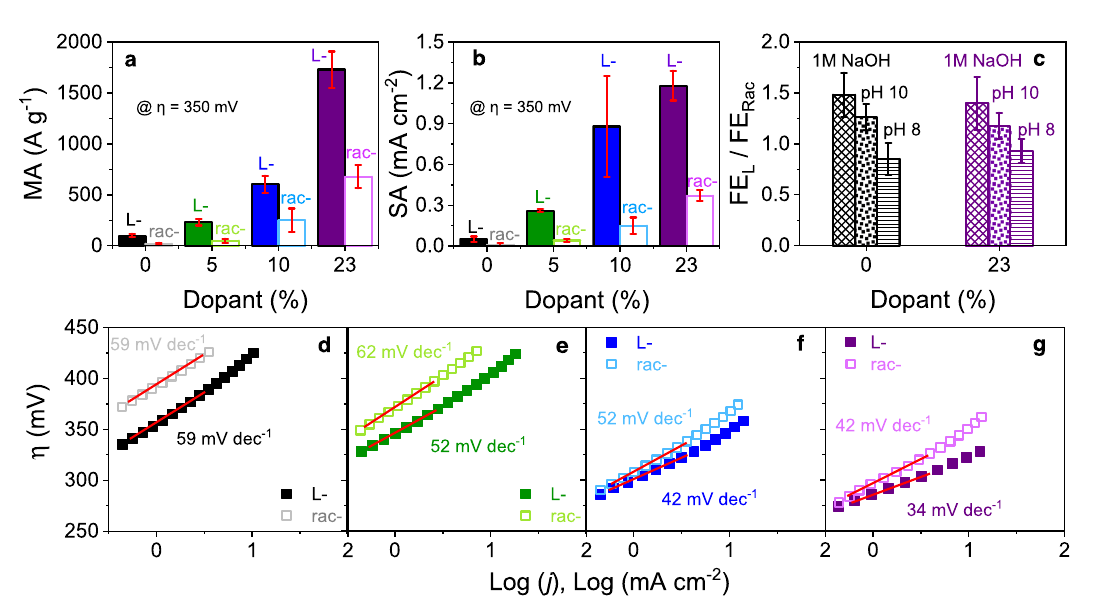
Fig. 3|Catalyticactivityandcharacterization. a , b Showmassactivity, “ MA ” and speci fi c activity “ SA ” of undoped (black) and 5% (green), 10% (blue), and 23% (purple)iron-dopedRac-(open)andL-cobaltoxide( fi lled)nanoparticlecatalystsin Na fi on measured in a 1M NaOH electrolyte solution. c Shows the enhancement in Faradaicef fi ciencyforundoped (black)and 23% Fe-doped (purple)chiralcatalysts, compared to their achiral analogs in 1M NaOH (horizontal dash) and in a 0.1M pH